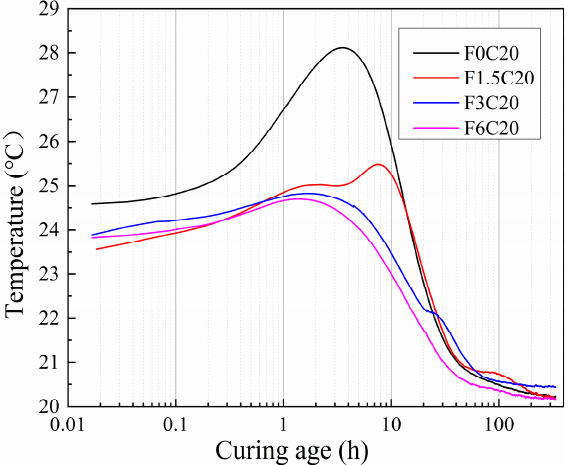
Figure 8. The hydration heat of CDS with different FA content.